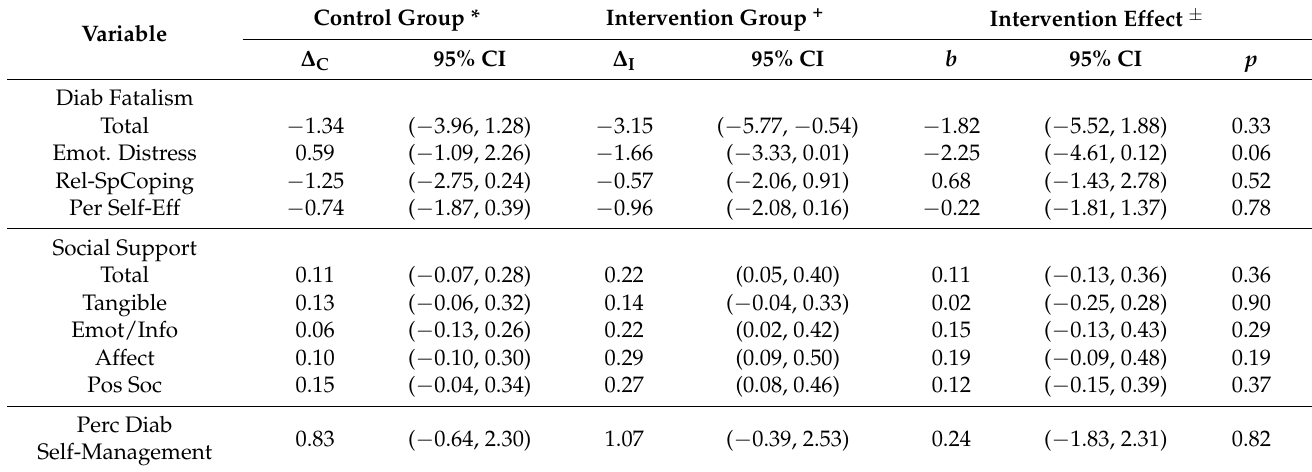
Table 2. Comparison of study outcomes for intervention and control groups.